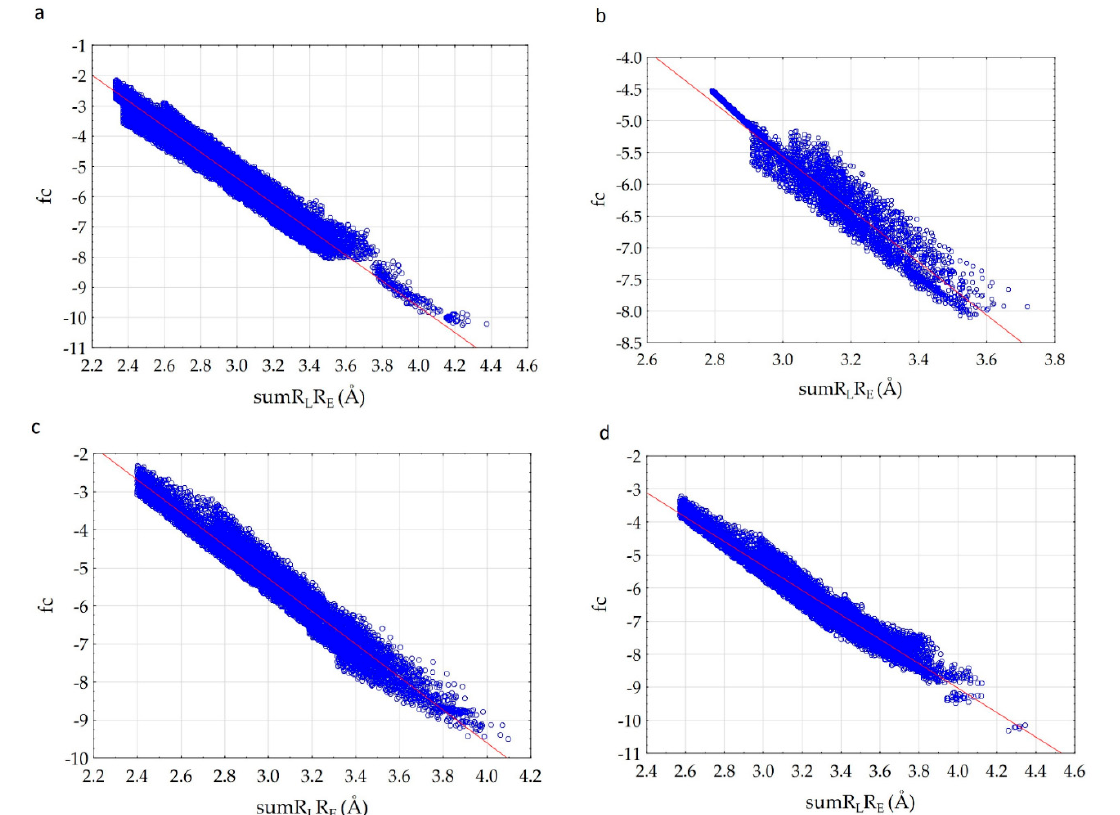
Figure 5. Correlation of complementarity factor (fc) with the sum of the distances (sumR L R E ): 7CTT enzyme—favipiravir-